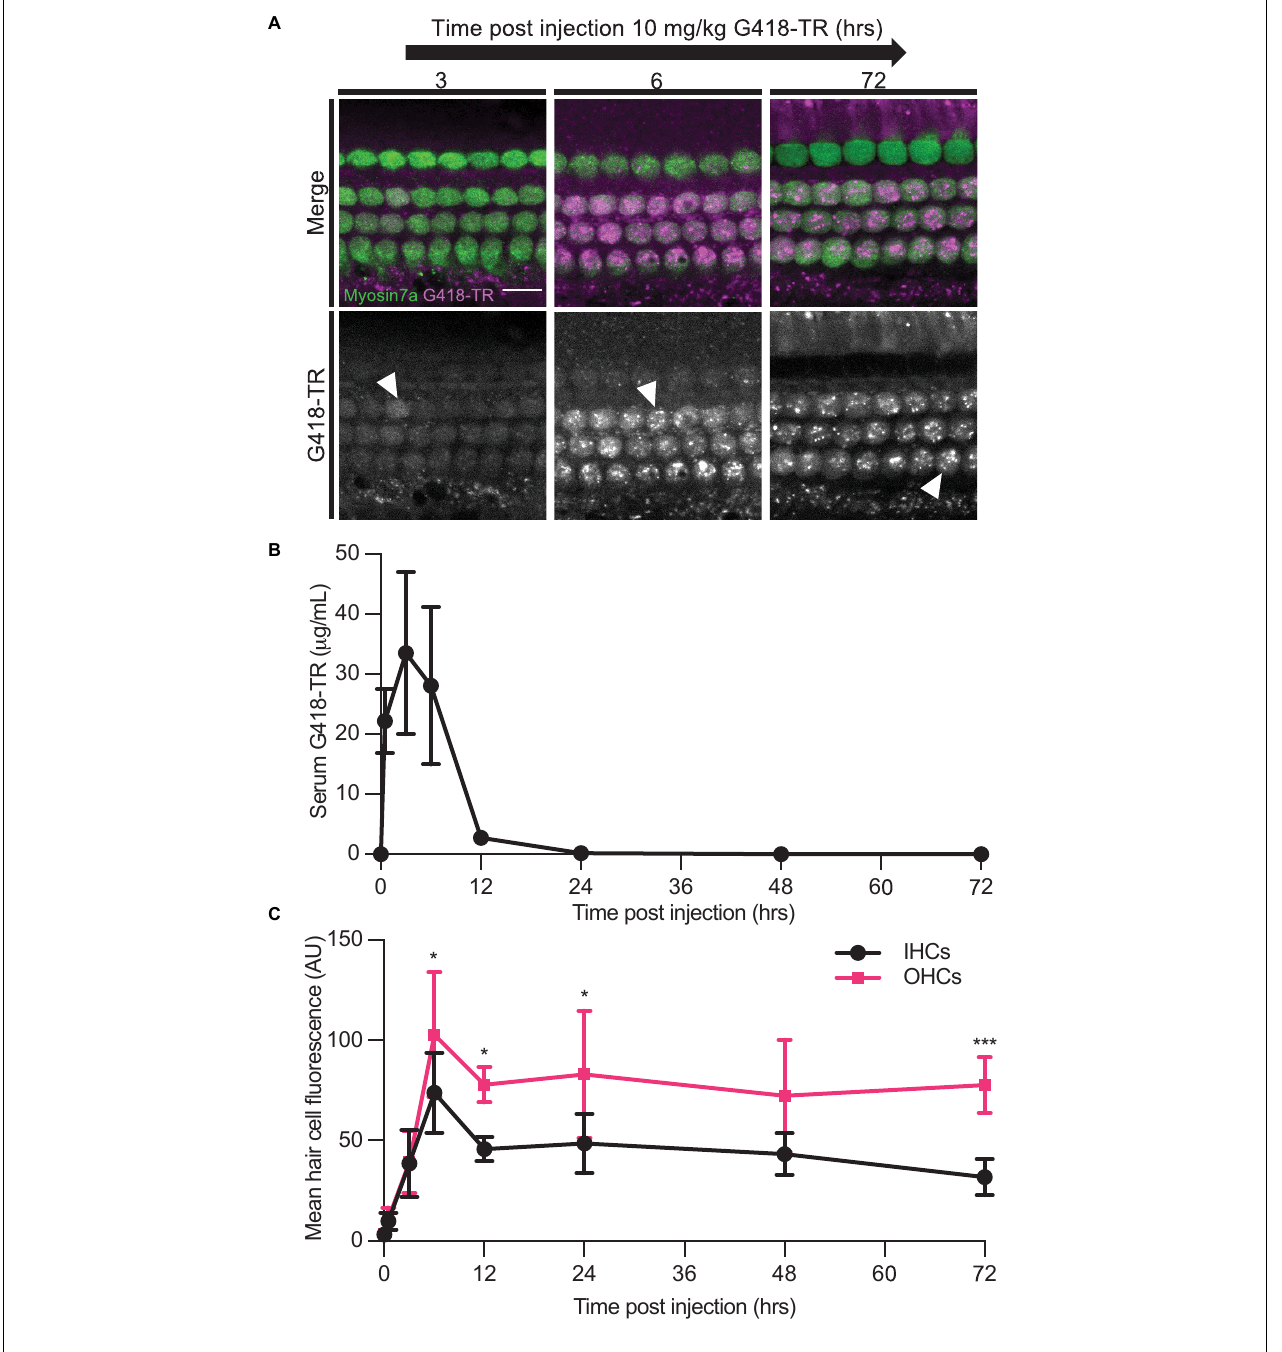
FIGURE 4 | Hair cells accumulate and retain G418-TR after systemic injection. (A) 30 min–72 h after systemic injection with 10 mg/kg G418-TR, neonatal mice (P5) were sacrificed, cochlear sensory epithelia was dissected and fixed, and tissue was immunolabeled for myosin VIIa. Representative images captured from the middle turn of the cochlea demonstrate uptake and retention of G418-TR. Images shown are single z-plane images capturing the region between the nucleus and cuticular plate. Arrowhead highlights transition from diffuse G418-TR distribution to accumulation in puncta with time. Scale bar = 10 µ m. (B) Serum kinetics of G418-TR after systemic injection. After systemic injection with 10 mg/kg G418-TR, neonatal mice were sacrificed at different time points, serum was collected, and fluorescence was quantified. Fluorescence was converted to concentration in µ g/mL utilizing a calibration curve of G418-TR diluted in fetal bovine serum. Quantification shows that serum levels of G418-TR peak at 3 h and are undetectable 24 h post-injection. (C) Mean hair cell fluorescence from the middle turn of the cochlea was calculated over 72 h. Both IHCs and OHCs show uptake and retention. Animals examined [ t (hours), n ] = (0,4), (0.5,4), (3,5), (6,6), (12,5), (24,5), (48,5), (72,5). Error bars are standard deviations. AU, arbitrary unit. Significant differences between IHC and OHCs denoted with: * P < 0.05, *** P < 0.001. P -values calculated from multiple comparisons post hoc test (Šídák’s multiple comparison test).